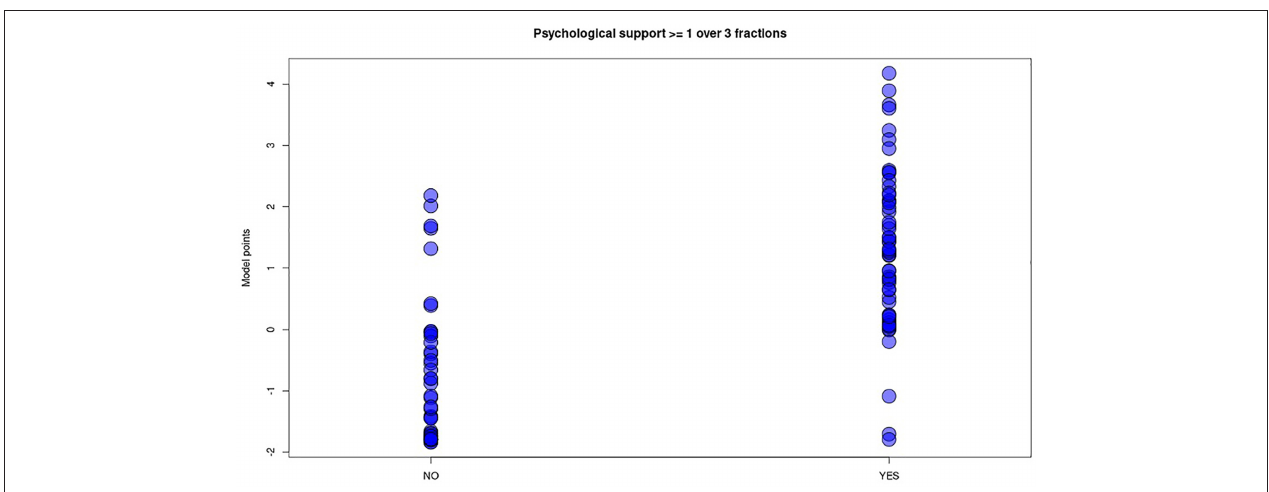
FIGURE 6 | Distribution plot of “psychological support” predictive model score (y axis) in the two groups of patients undergoing (YES) or not (NO) to intensive psychological support. The blue dots represent each patient in the two groups. Differently from “anesthesia” model no threshold line has been plotted, being wide overlapping between the two categories of patients despite fair model performances.